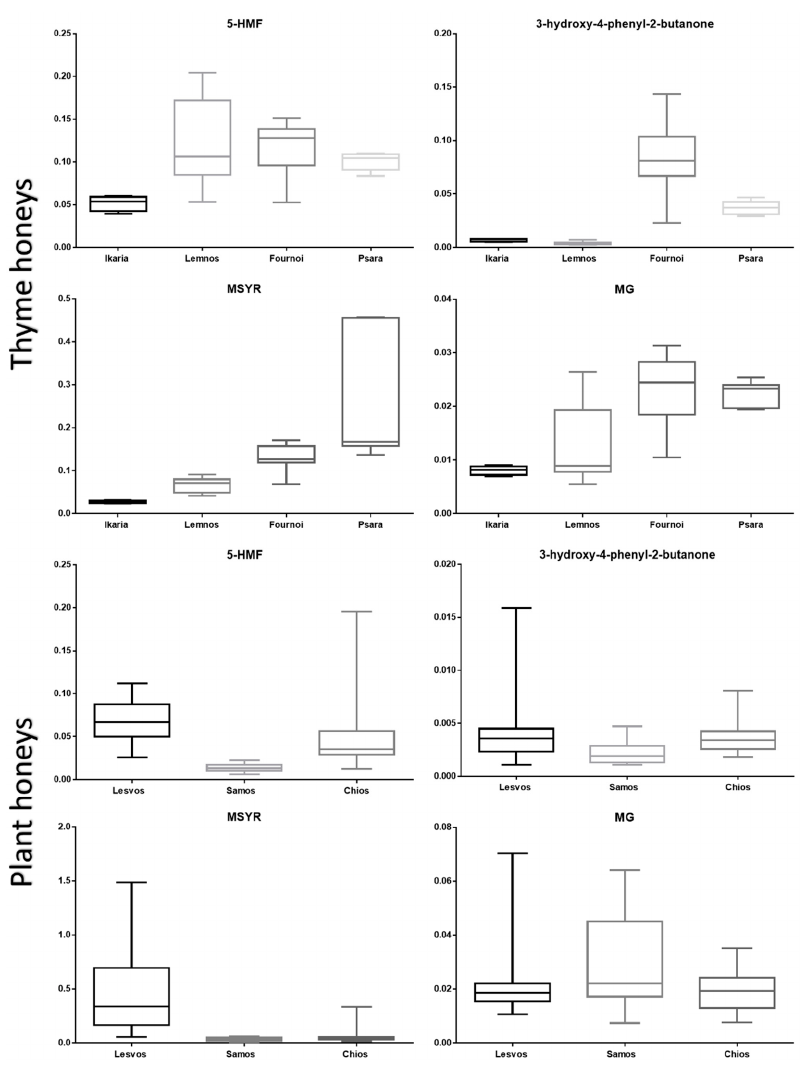
Figure 5. Box plots of statistically significant biomarkers based on their geographical origin ( p- value ≤ 0.05 was considered as statistically significant). All p- values can be found in Tables S7 and S8.